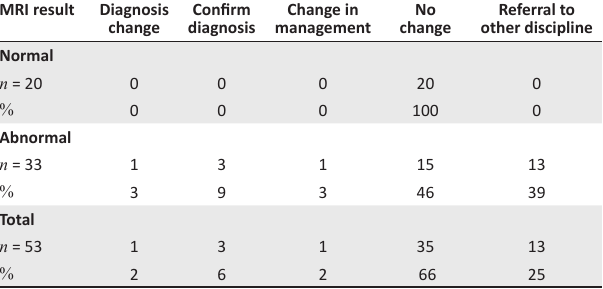
TABLE 4: Clinical outcome according to magnetic resonance imaging result. MRI result Diagnosis Confirm change